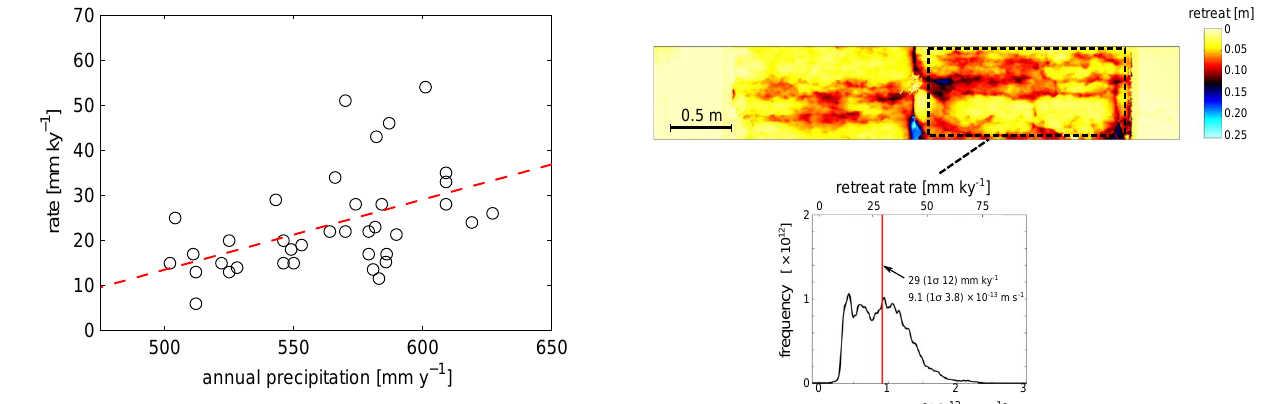
Figure 1. Limestone weathering rates for a restricted range of an- nual precipitation in the eastern Mediterranean. Although precipi- tation is thought to be the dominating factor, the variance for any given level of precipitation is large, with values deviating from the least-squares fit line by over 100%. Data compiled from Ryb et al. (2014a) and Ryb et al. (2014b).